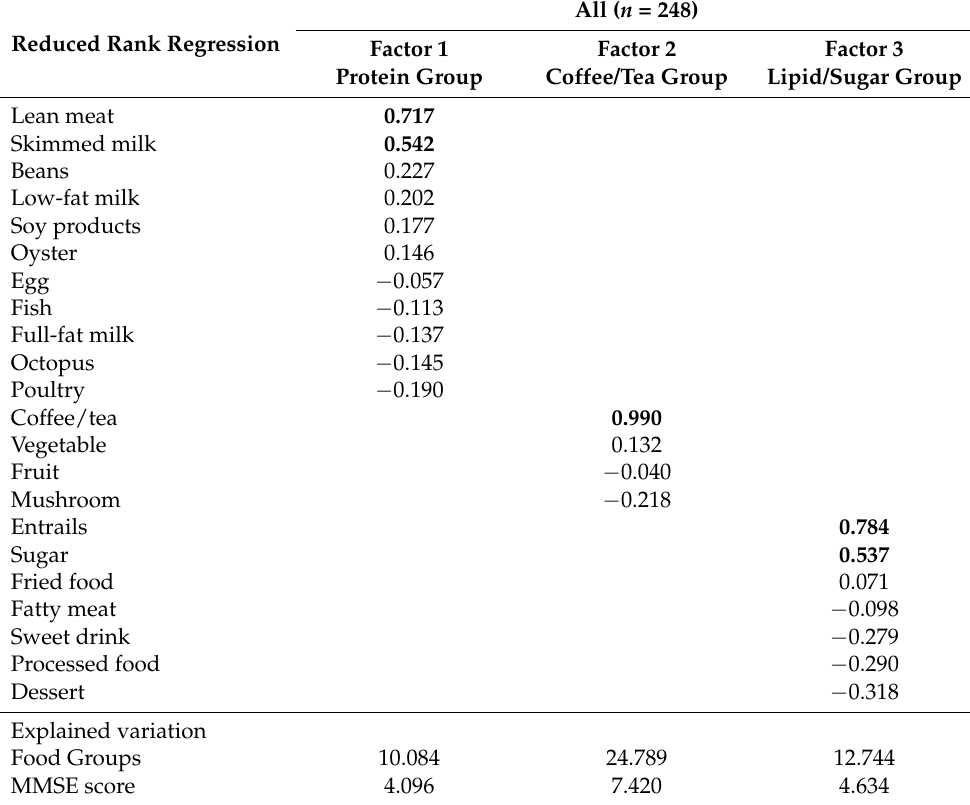
Table 1. Factor loadings for an optimal linear combination of 22 food